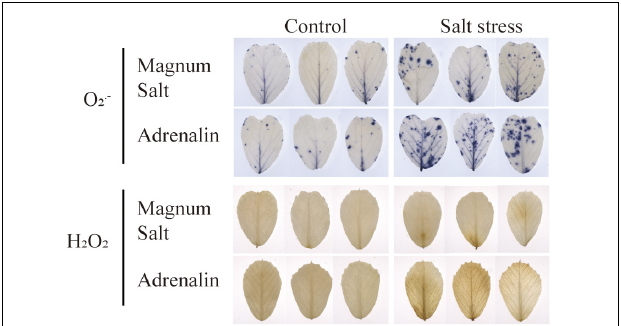
FIGURE 5 | Effect of salt treatment on the ROS content in Magnum Salt and Adrenalin. Four-week old seedlings grown in soil with a mixture of pearlite, vermiculite and perlite (1:1:2) were treated with 0 or 500 mM NaCl for 6 days. Leaves were sampled for NBT and DAB staining.